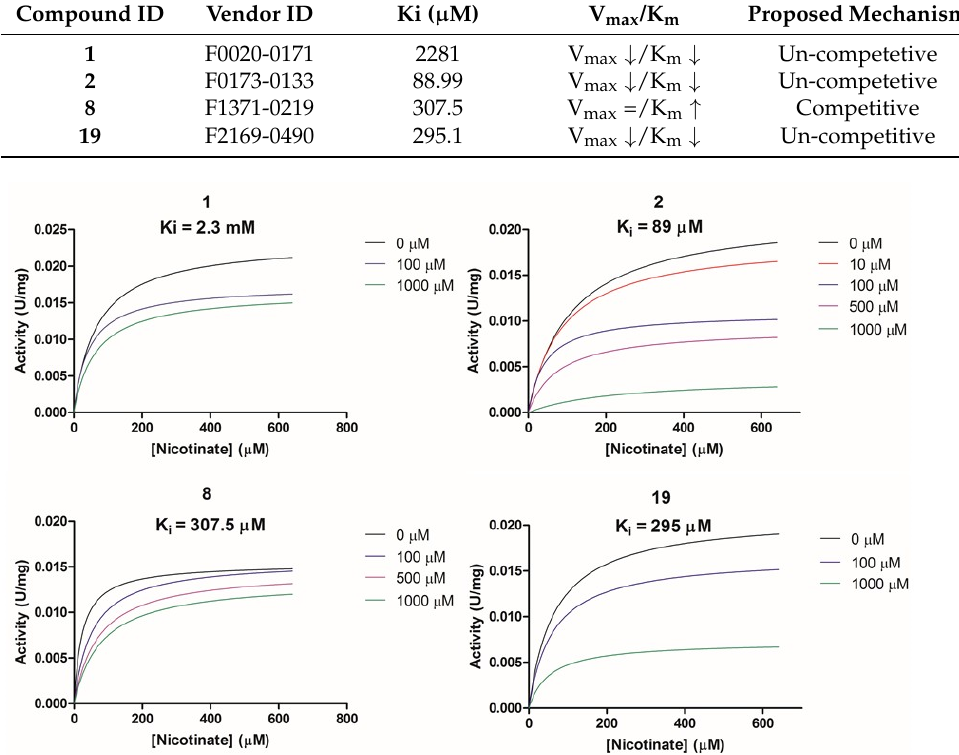
Table 3. Proposed mechanism of action for putative NAPRT inhibitors.